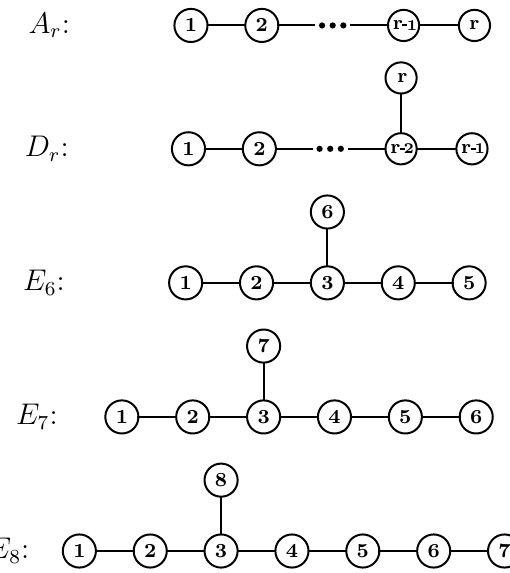
Figure 1 . ADE Dynkin diagrams with numbers specifying the